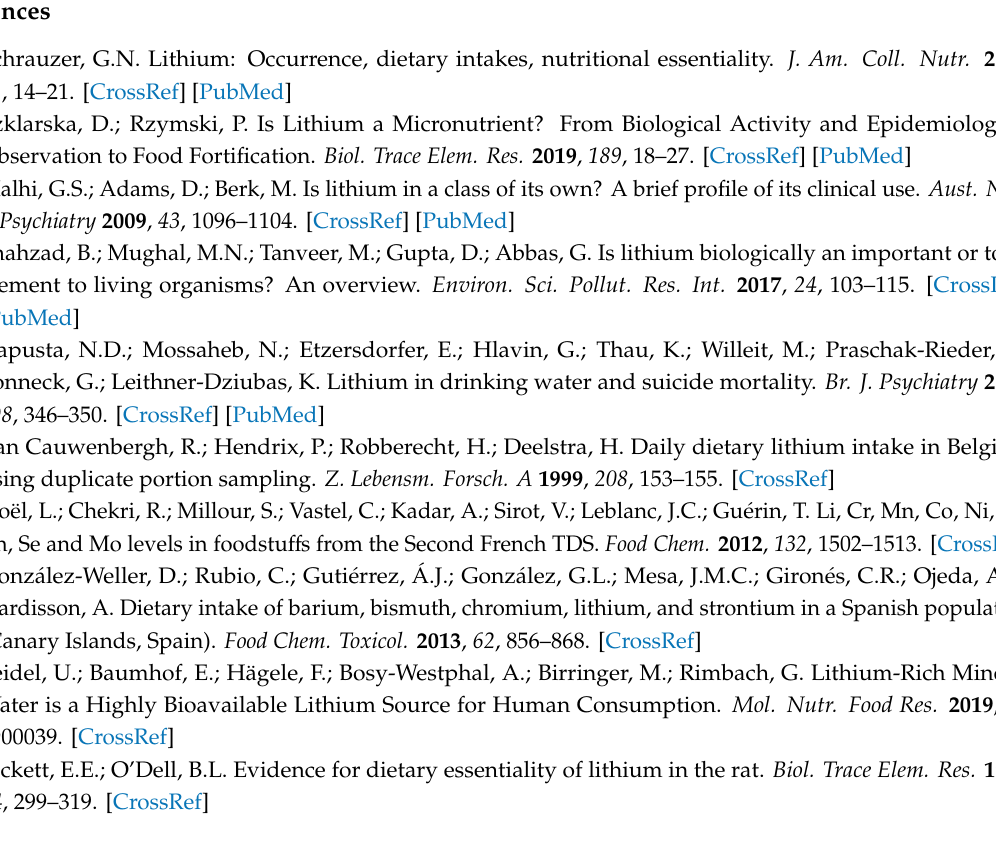
Table S1: Circulating plasma lithium concentration according to season ( n =